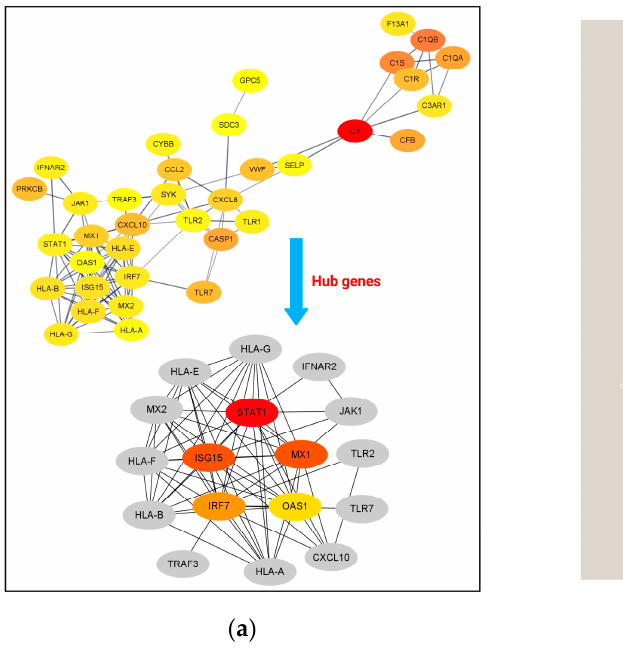
Figure 8. Interactome analysis of shared DEGs among DKD and COVID-10 pathways. ( a ) PPI network of DEGs and their closest interactors. Edges represent experimental validated interactions among proteins with a high score value (0.7). Hub genes were retrieved from cytoHubba and are shown according to score nodes (from yellow to red); ( b ) Interactome of the five identified hubs genes. Each node represents a gene and the edges between nodes represent regulatory interactions among genes. The big, highlighted nodes with specific color represent each of the hub genes, while nodes sharing the same color surrounding these represent co-expressed gene modules. Enriched biological processes of each module are depicted in the same color as well. STAT1 (red); OAS1 (turquoise); ISG15 (pink); IRF7 (navy blue); MX1 (green).